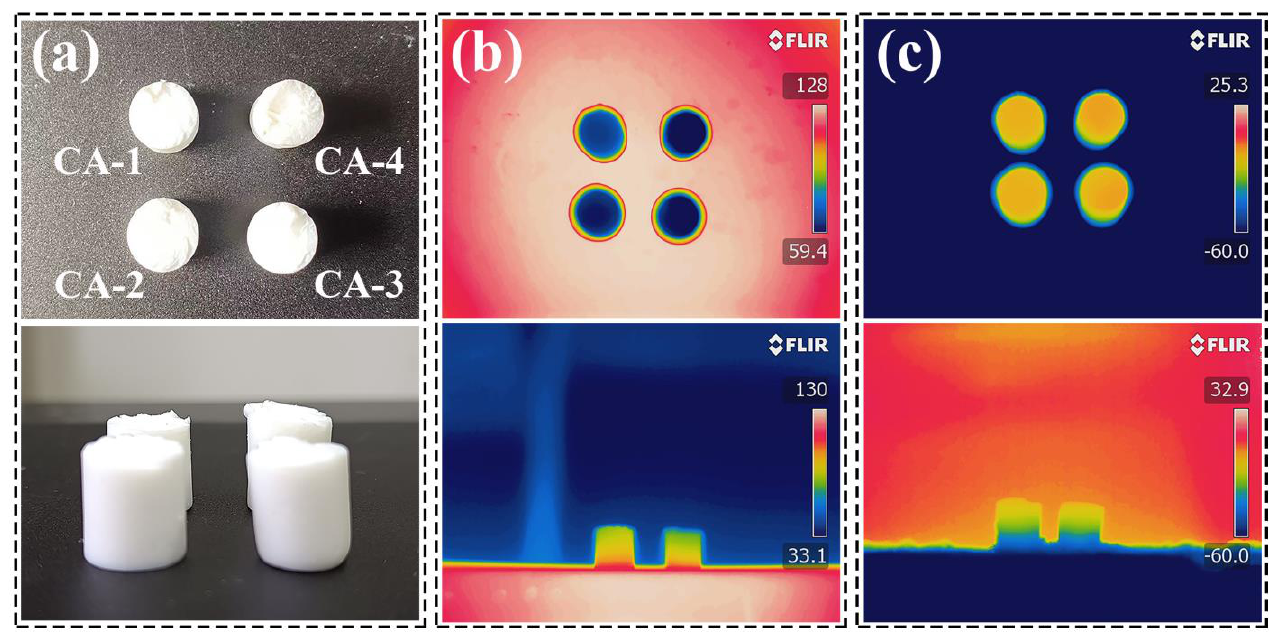
Figure 6. ( a ) Optical photo of the main and side views, respectively, of the CAs. FLIR images of the CAs ( b ) on the heating base plate at 130 °C and ( c ) on an aluminum plate of dry ice ( – 60 °C) for the main and side views, respectively.